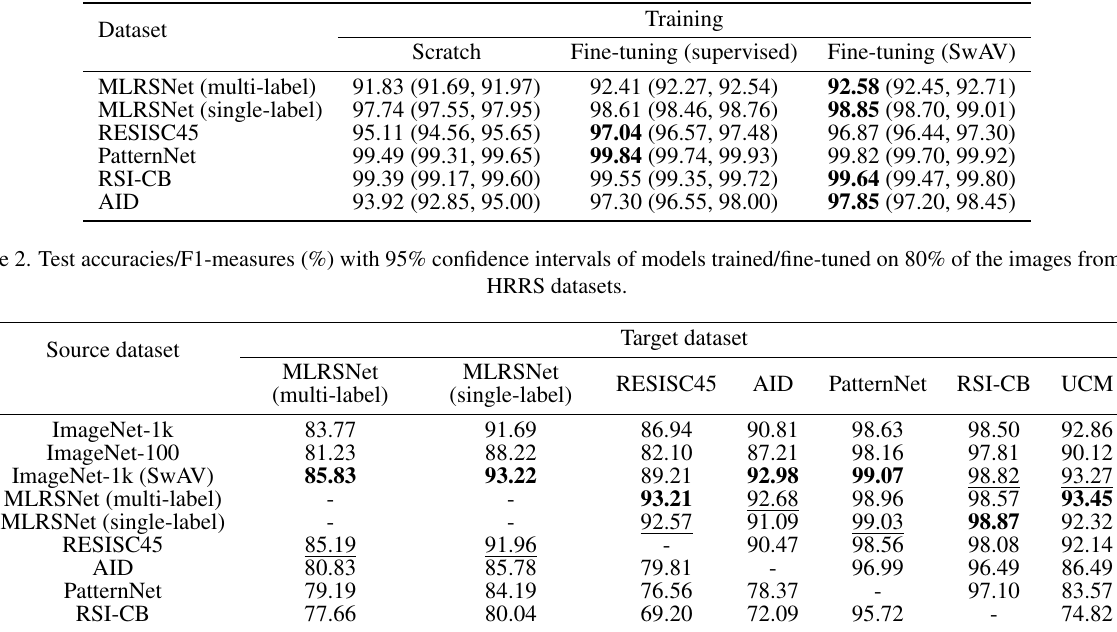
Table 1. Details of HRRS image datasets used in the experiments.